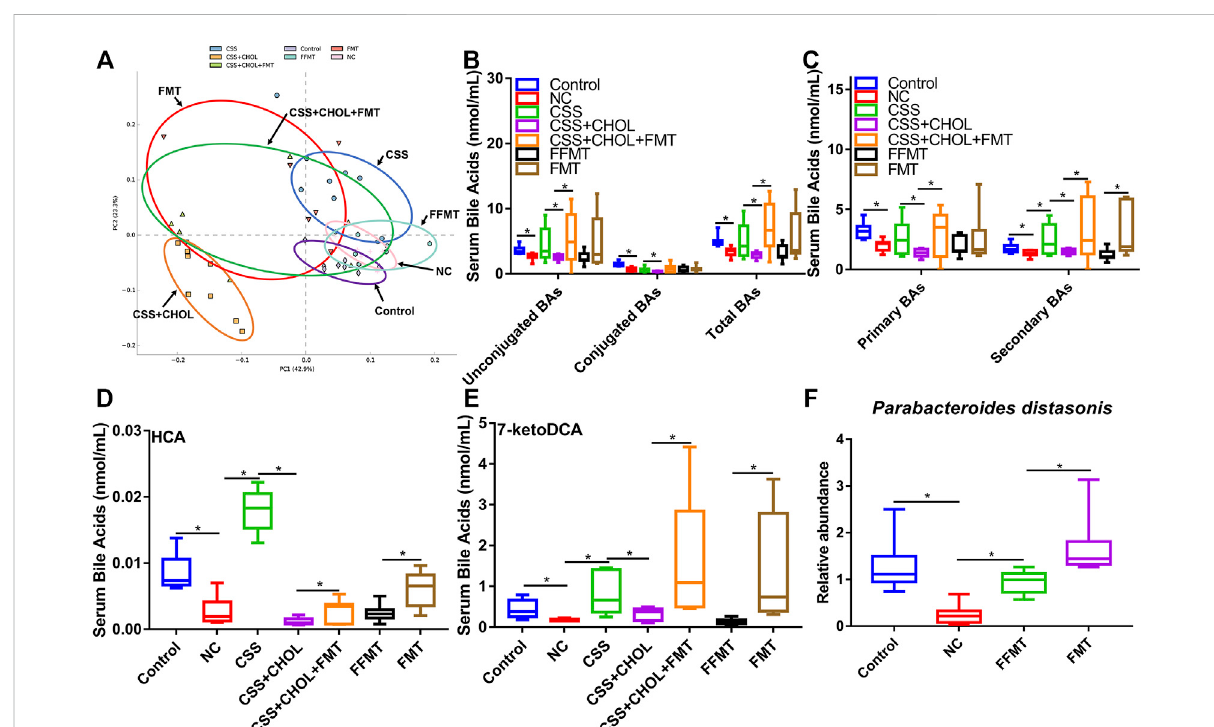
FIGURE 7 Transplantation of microbiota from CSS-treated mice into untreated mice restores serum BA levels in CUMS mice. MS was used to measure levels of BAs in serum from control mice as well as mice exposed to CUMS and treated with saline (NC), CSS, or CSS along with the BA sequestrant CHOL; or fecal contents (un fi ltered or fi ltered) from CSS-treated mice (FMT and FFMT, respectively). (A) PCA plot comparing serum BA concentrations between groups. (B) Levels of unconjugated, conjugated and total BAs in serum collected from different groups. (C) Levels of primary and secondary BAs in serum collected from different groups. (D,E) Serum levels of (D) HCA, and (E) 7-ketoDCA in each group. (F) Relative abundance of Parabacteroides distasonis (detected by RT-qPCR) in colon contents of control mice or mice exposed to CUMS and treated with saline, FMT, or FFMT. All values are expressed as means ± S.D. An asterisk “ * ” indicates p <